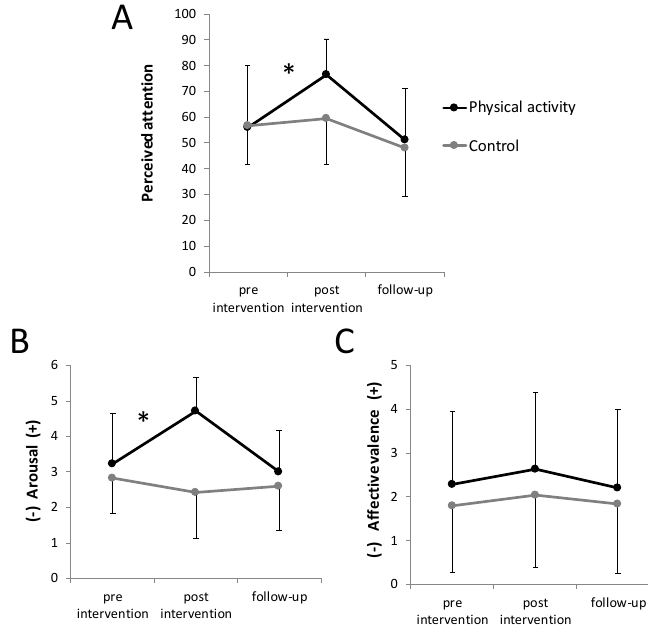
Figure 4. Perceived attention ( A ), arousal ( B ), and affective valence ( C ) over time for each group separately. Error bars represent standard deviations. * indicates a significant group by time interaction.